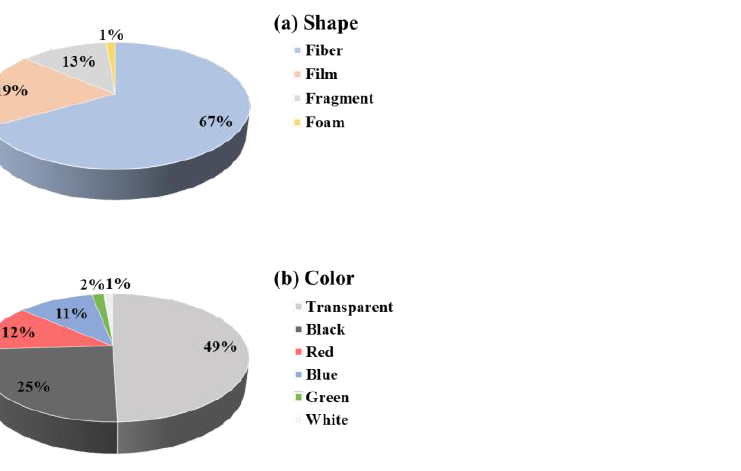
Figure 3. Microplastic abundance in marine organisms of the Zhoushan fishing ground, categorized by ( a ) shape and ( b ) color.